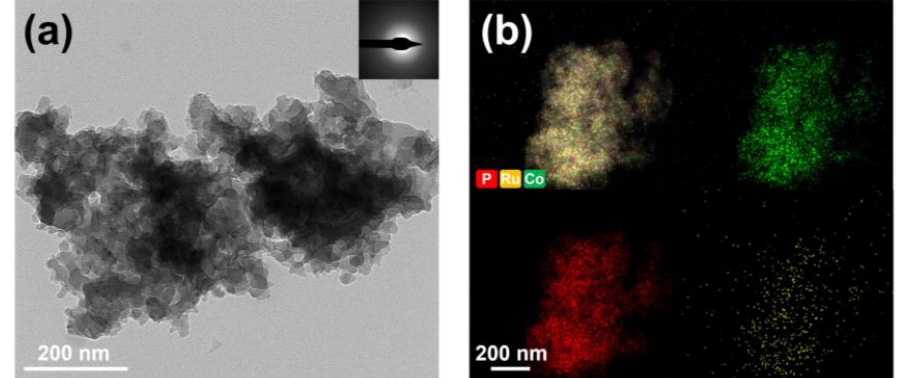
Figure 2. ( a ) TEM and ( b ) elemental-distribution images of CoRuP/SiO 2 .